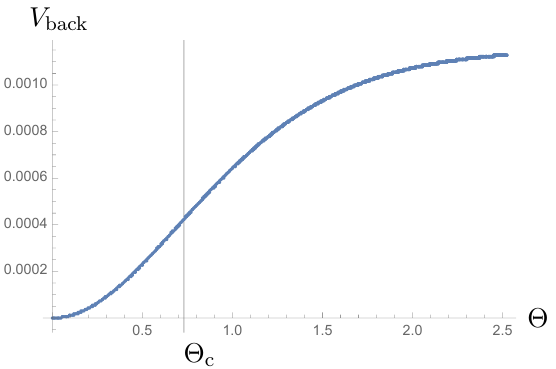
Figure 1 . The backreacted potential V back ((cid:2)) (after adding a constant uplift) depending on the proper (cid:12)eld